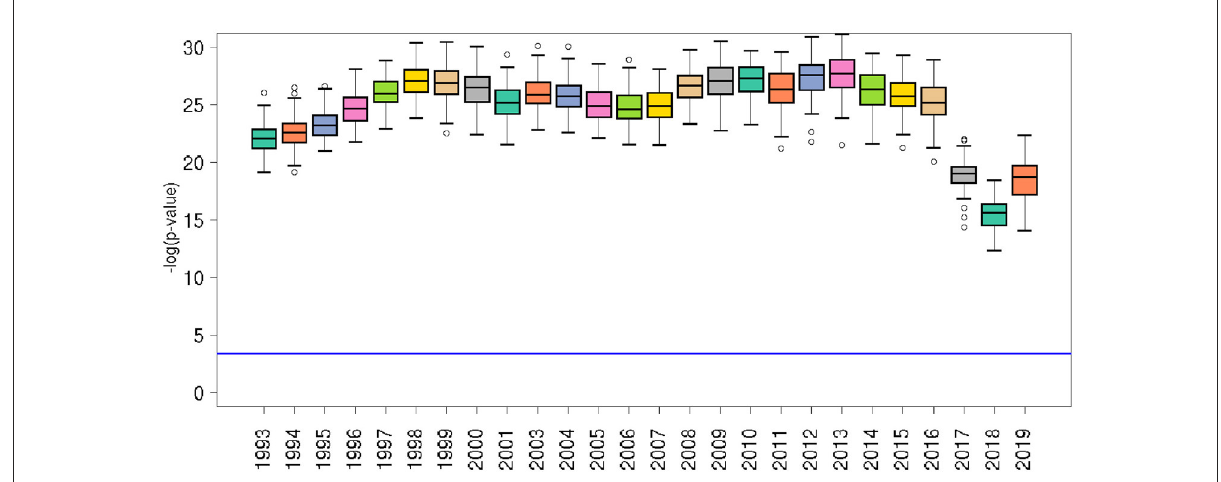
FIGURE4 Significance of the RF model for each year, in terms of the relative p -value of the agreement ( R 2 ) between PAD actual values and RF predictions for each year. The horizontal blue line represents the p = 0.01 after correction for multiple hypothesis testing according to Bonferroni. Empty bullets represent distribution